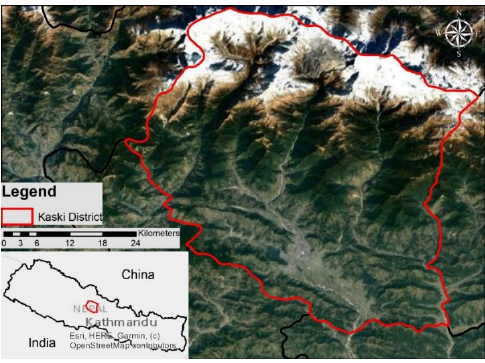
Figure 2. Location map of the Kaski district, Nepal, with natural color cloud-free Landsat composite.